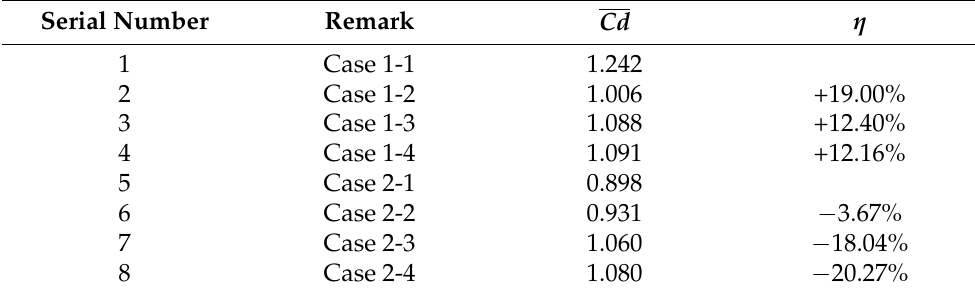
Table 6. The drag reduction rates of included cases.